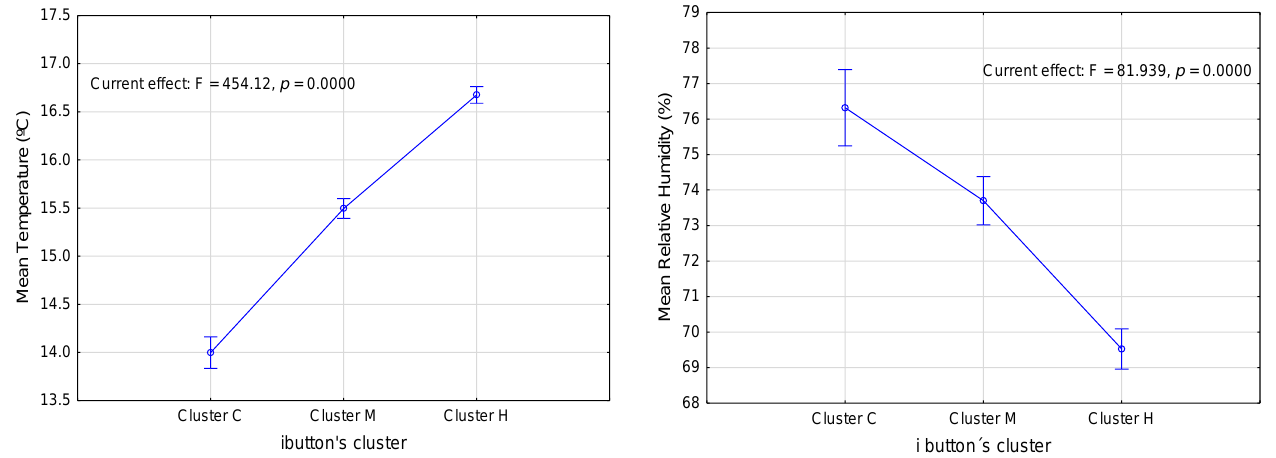
Figure 3. Less square mean graphs (vertical bars denote 0.95 confidence intervals) for clusters of ibuttons according to identified temperature and relative humidity inside the reefer during the whole transport itinerary (Jandaíra, Brazil to Castellón, Spain).